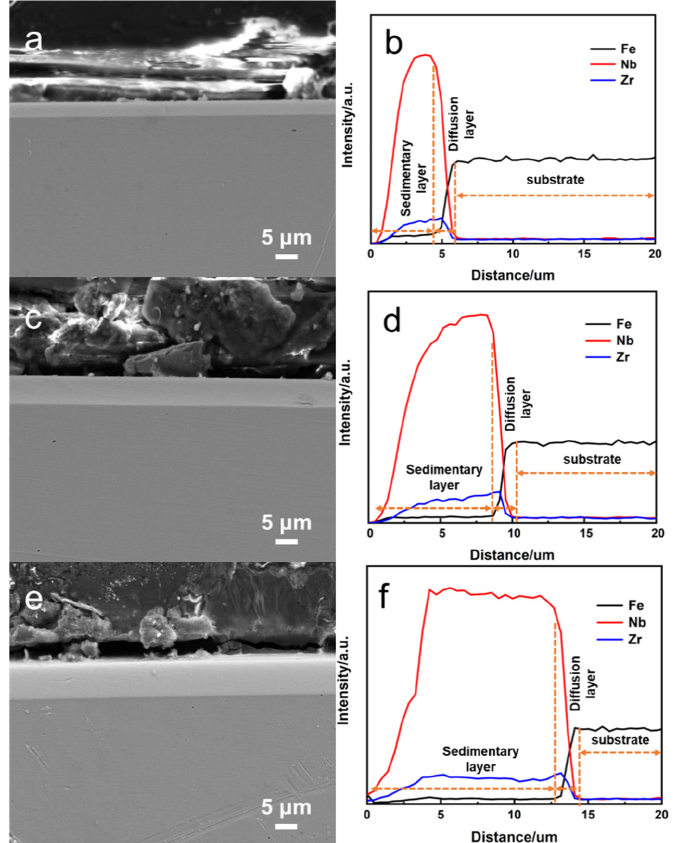
Figure 5. SEM images of cross-sections and changes in element content of Nb-Zr alloying layers at ( a , b ) 30 Pa, ( c , d ) 40 Pa, and ( e , f ) 50 Pa.